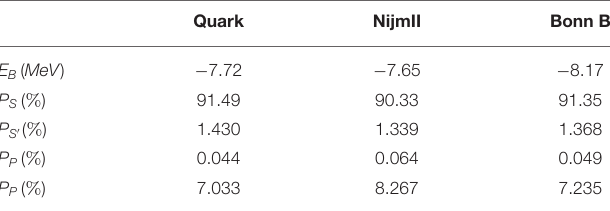
TABLE 5 | Comparison of triton properties from Juliá-Díaz et al. [80]. Quark